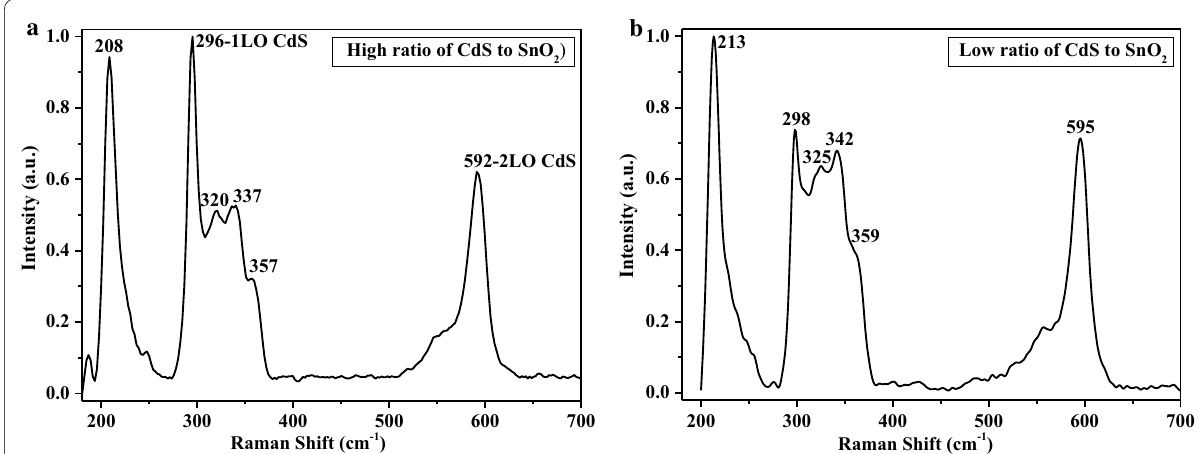
Fig. 3 a , b Micro-Raman scattering spectra of single Sn-doped CdS nanowire synthesized with high and low ratio of CdS to SnO 2 , by using He–Ne laser (632.8 nm) as excitation light